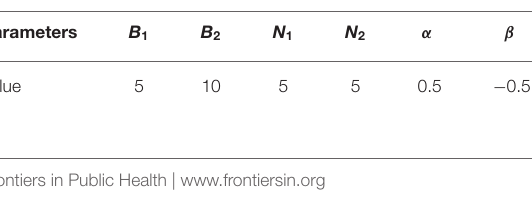
TABLE 3 | Parameter settings of consumers.